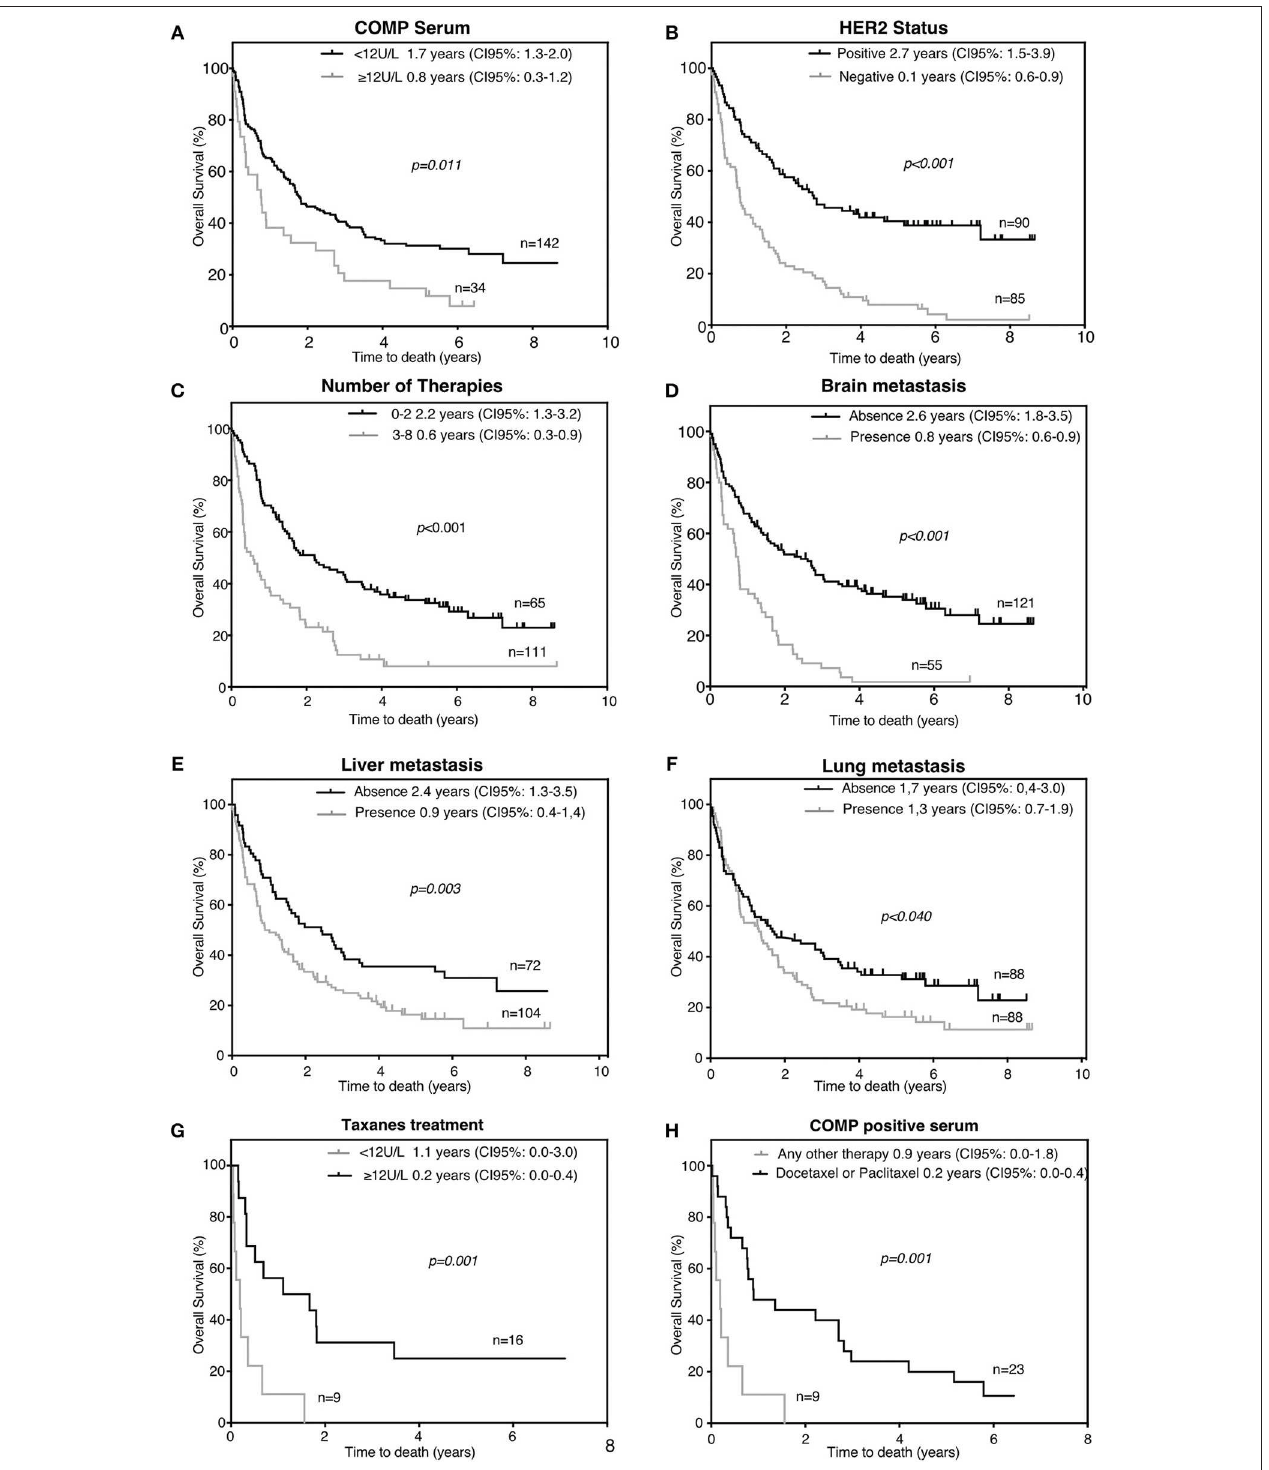
FIGURE 3 | Factors associated with decreased overall survival (OS) of the metastatic patients ( n = 176). High serum COMP levels (A) , HER2 negativity (B) , number of previous therapies (C) , presence of brain (D) , liver (E), or lung (F) metastases were correlated with lower OS. (G) High serum COMP levels are associated with worse OS in patients treated with taxanes. (H) Breast cancer metastatic patients with positive serum COMP ELISA had poorer OS when taxanes was used as part of their first line therapy. Kaplan-Meier analysis with Breslow’s test was used, p < 0.05 were considered significant, and survival is presented as the median.